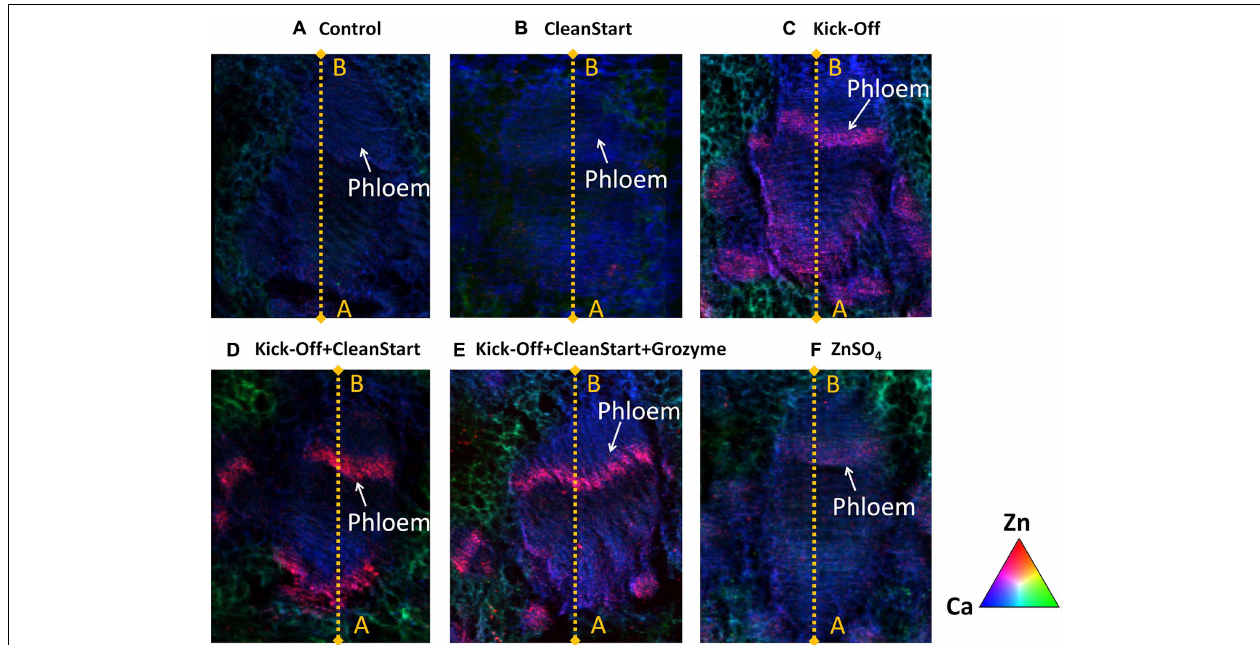
FIGURE 3 | Micro X-ray fluorescence elemental maps for Zn (red), Ca (green), and K (blue) focused on vascular bundles of petioles collected from sunflowers subject to different foliar fertilizers. Full expanded leaves of sunflower were treated with (A) control, (B) CleanStart, (C) Kick-Off, (D)